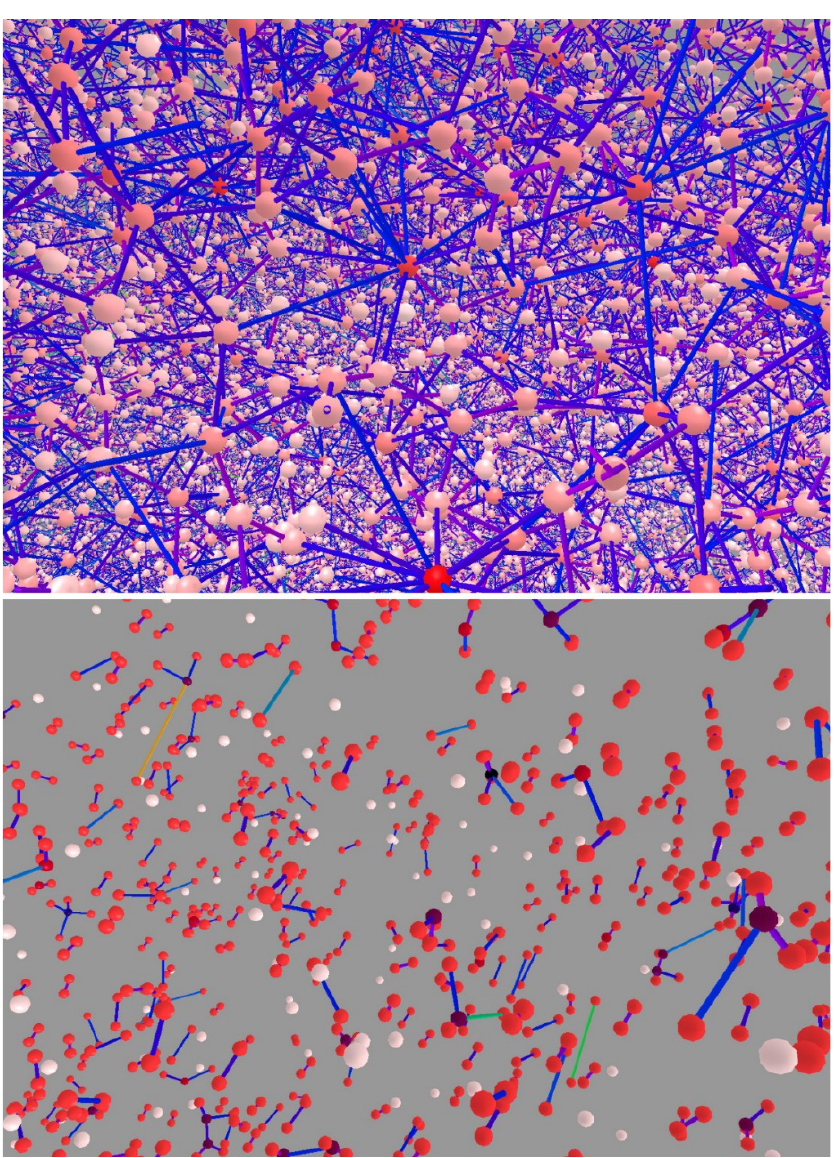
Figure 15. Sparse graphs of pores: ( upper ), low-fired ceramic 1; ( lower ), high-fired ceramic 12. Pores are colored by connectivity, with dark red for high connectivity down through degrees of red to white for low connectivity. Connections color-coded by length.